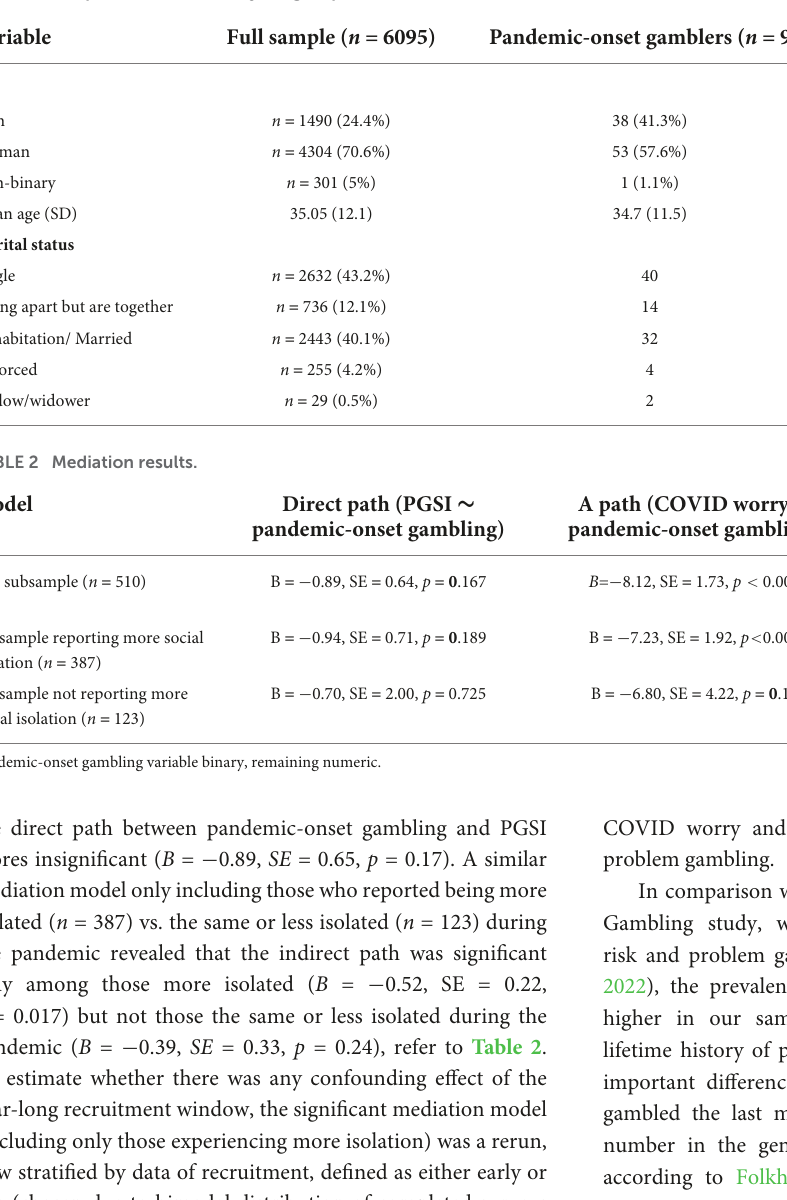
TABLE 1 Sample characteristics by subgroup.